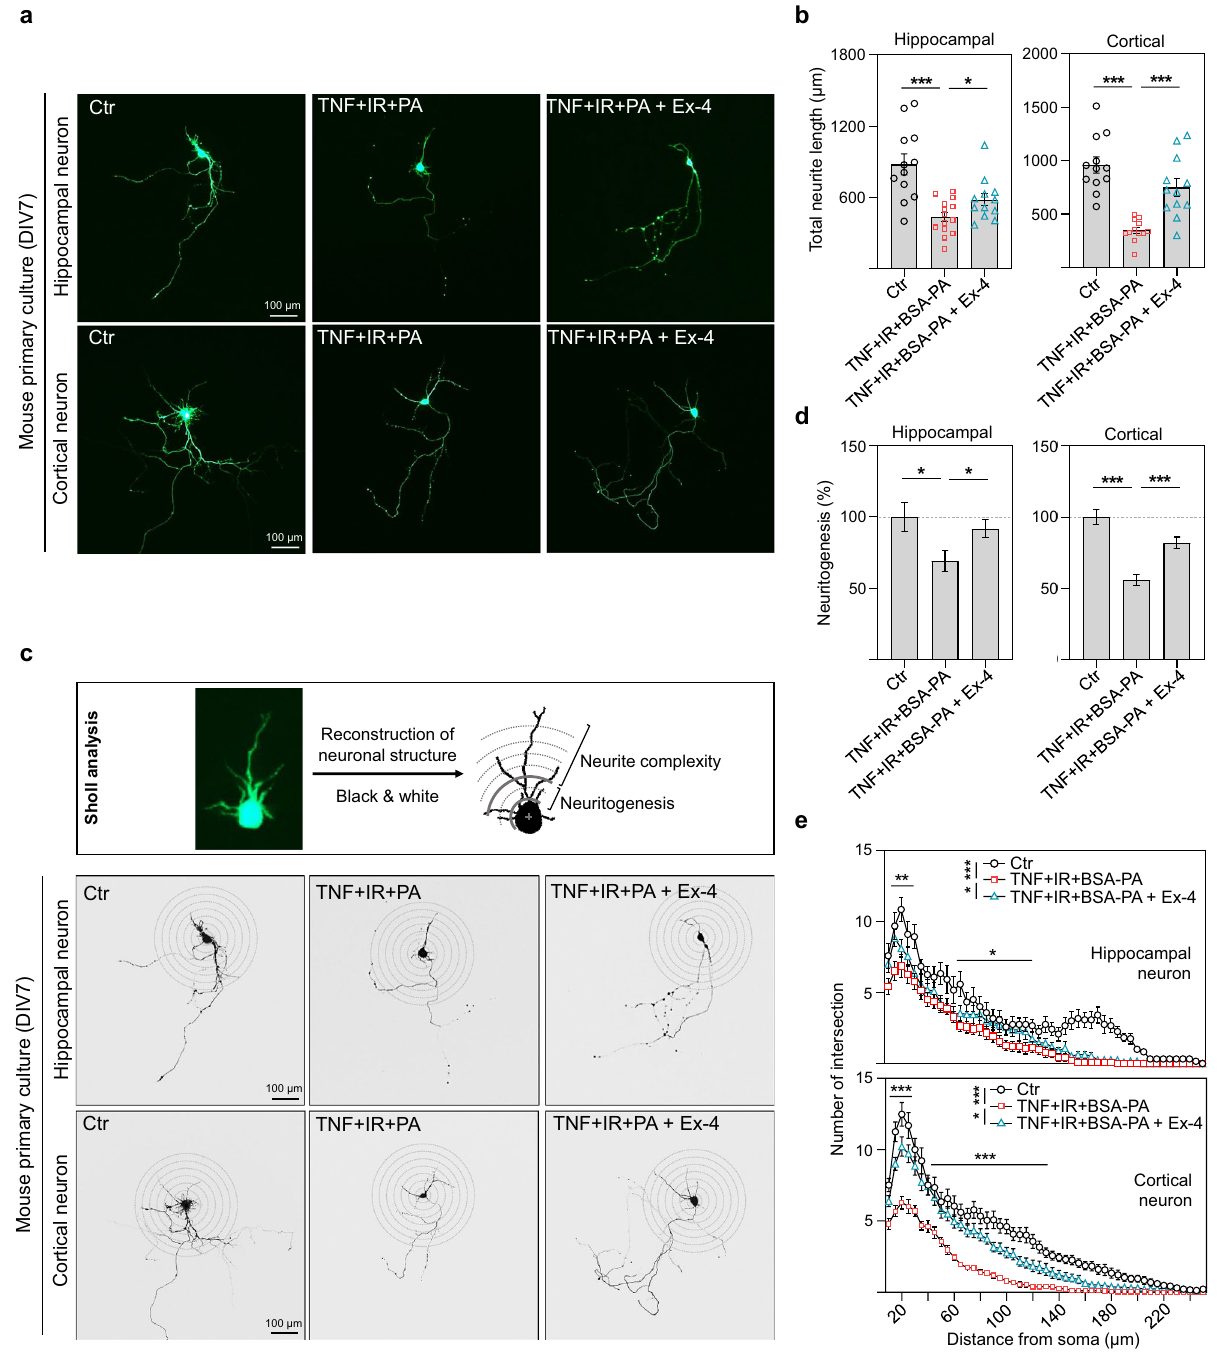
Figure 1. Exendin-4 improved neural complexity of in vitro neurons in metabolic imbalance conditions. ( a ) Representative images (×40) of GFP-positive primary hippocampal and cortical neurons at DIV 7 after treatment with a combination of inducers of metabolic imbalance such as TNF-α, insulin, glucose, palmitate, and a therapeutic agent exendin-4. ( b ) Histogram of total neurite length change after treatment of metabolic imbalance factors and exendin-4 in mouse primary hippocampal and cortical neurons at DIV 7. ( c ) Representative images of reconstructed primary hippocampal and cortical neurons of ( a ). A Sholl analysis was conducted after converting the GFP signal to a black and white reconstruction. The diameter of the first sholl covering the soma was 10 μm, and the radius of the sholl increased by 5 μm. ( d ) Histogram of neuritogenesis change after treatment of metabolic imbalance factors and exendin-4 in mouse primary hippocampal and cortical neurons at DIV 7. ( e ) Histogram of neurite complexity change after treatment of metabolic imbalance factors and exendin-4 in mouse primary hippocampal and cortical neurons at DIV 7. Data information: Ctr.: control, TNF: 25 ng/ml TNF-α, IR: insulin resistance (treatment of 100 nM insulin and 4.5 g/L d-glucose), BSA-PA: 50 μM BSA- conjugated palmitate, Ex-4: 10 nM exendin-4. The length of the scale bar is included in the representative images. Data are expressed as the group mean ± standard error of the mean. In ( b ), ( d ), and ( e ), data are expressed from 12 neurons per independent group in triplicate. Statistical analyses examined the relative significance between each group [( b ) and ( d ): unpaired two-tail t -test with Welch’s correction; ( e ) Two-way ANOVA with Bonferroni post-test to compare the replicate means by distance from the soma). n.s. P < 0.05, *P < 0.05, **P < 0.01, and ***P <